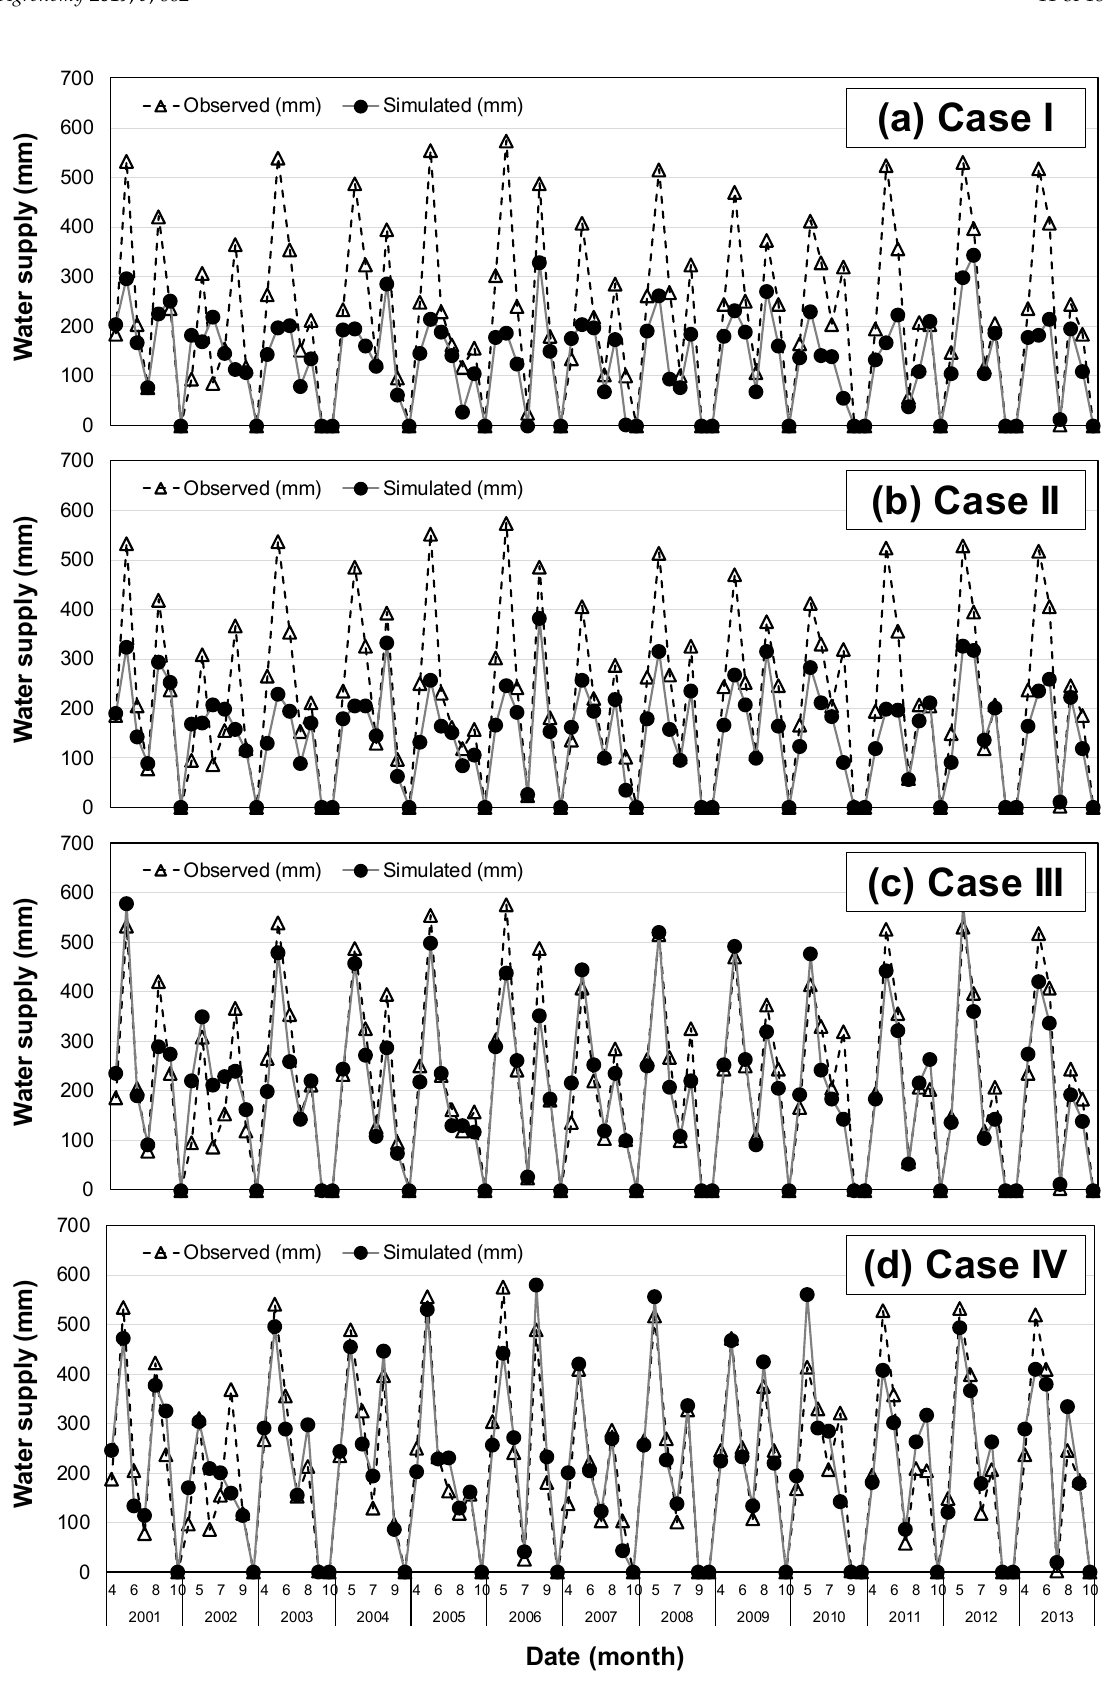
Figure 5. Time-series plots of observed vs. simulated agricultural water supply.